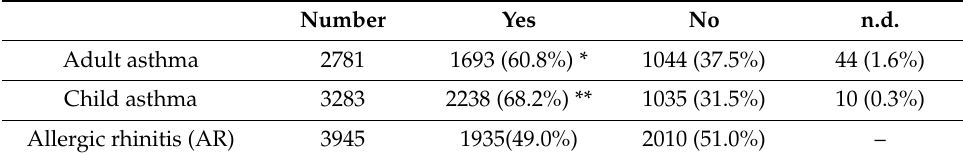
Table 2. Comorbidity of Asthma with Allergic